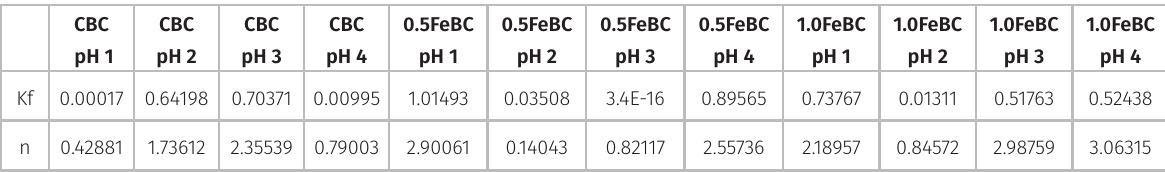
Table V. Parameters for Freundlich